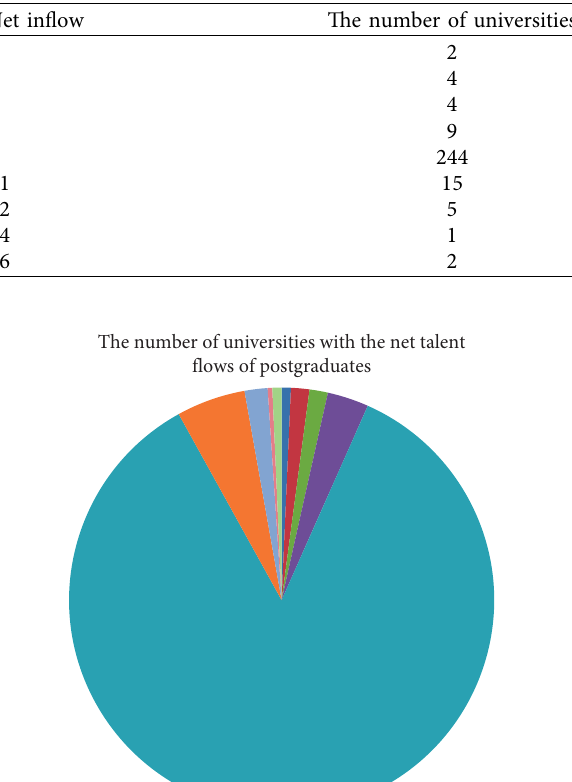
Table 6: The ranking of the attraction of doctoral students (top